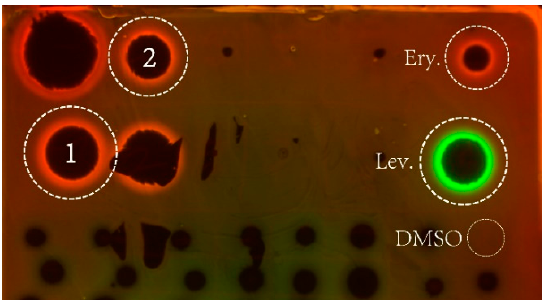
Figure 6. Agar plate coated with a layer of reporter strain JW5503 ( Δ tolC ) of E. coli that was transformed by plasmid pDualrep2. Spots of erythromycin (Ery), levofloxacin (Lev), DMSO, and Compounds 1 and 2) were placed on the surface of the agar plate. The plate was scanned in the Cy3 and Cy5 channels to determine RFP andKatushka2S fluorescence, respectively, and showed a combined image where RFP and Katushka2S fluorescence were shown in green and red hues, respectively. Fluorescence of RFP protein-induced DNA damaged SOS response; while, Katushka2S indicates translation inhibition.